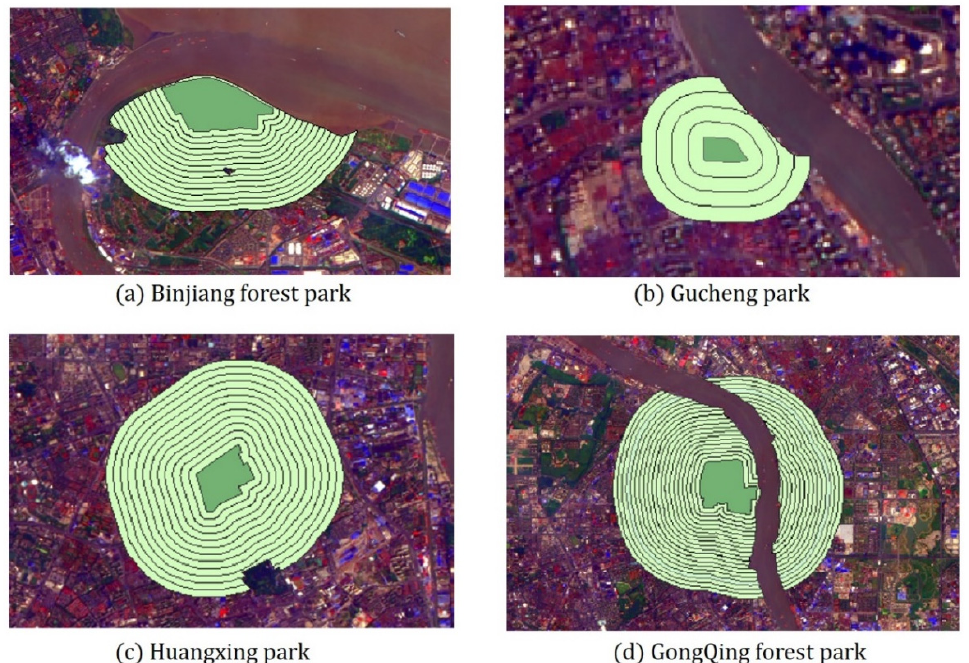
Figure 6. Four examples of parks’ buffer zones. Table 5. Maximum cooling distance and maximum cooling intensity of the 24 parks in Shanghai.